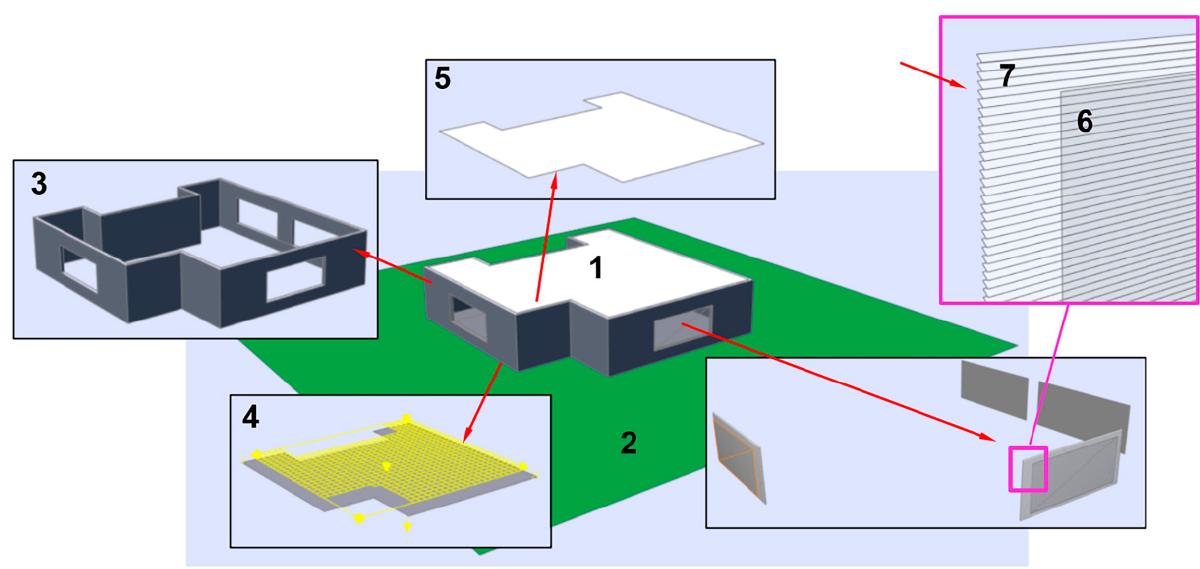
Figure 4. Scheme of the second verification scene.